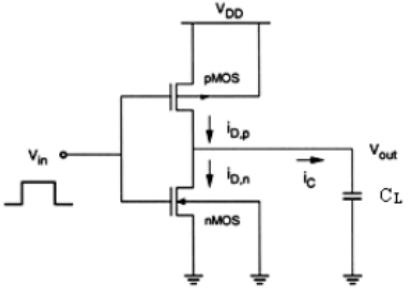
Figure 1: Schematic diagram of a CMOS inverter.